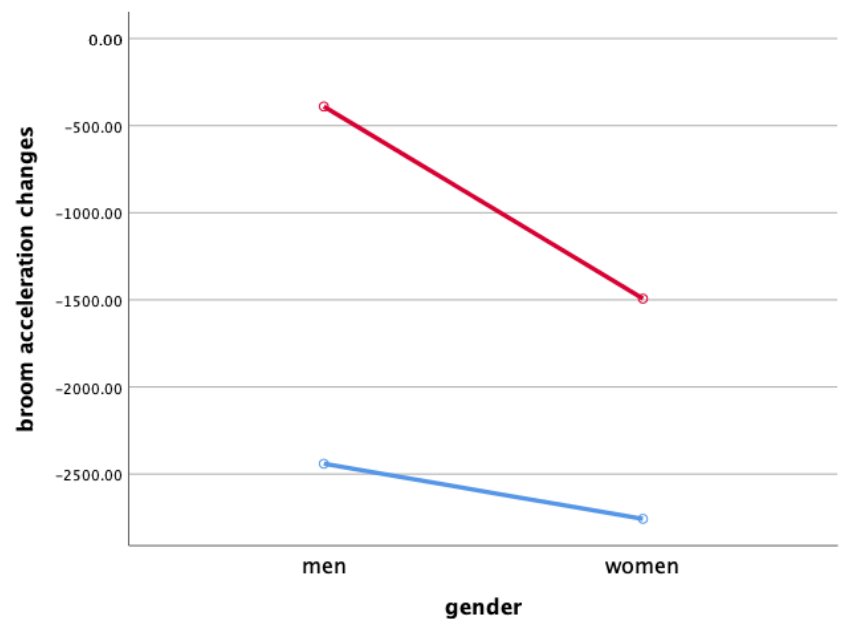
Figure 4. Broom Acceleration Changes When Sweeping(Y)—interaction effect (mG). Red line: along the axis of motion, blue line: perpendicular to the axis of motion.